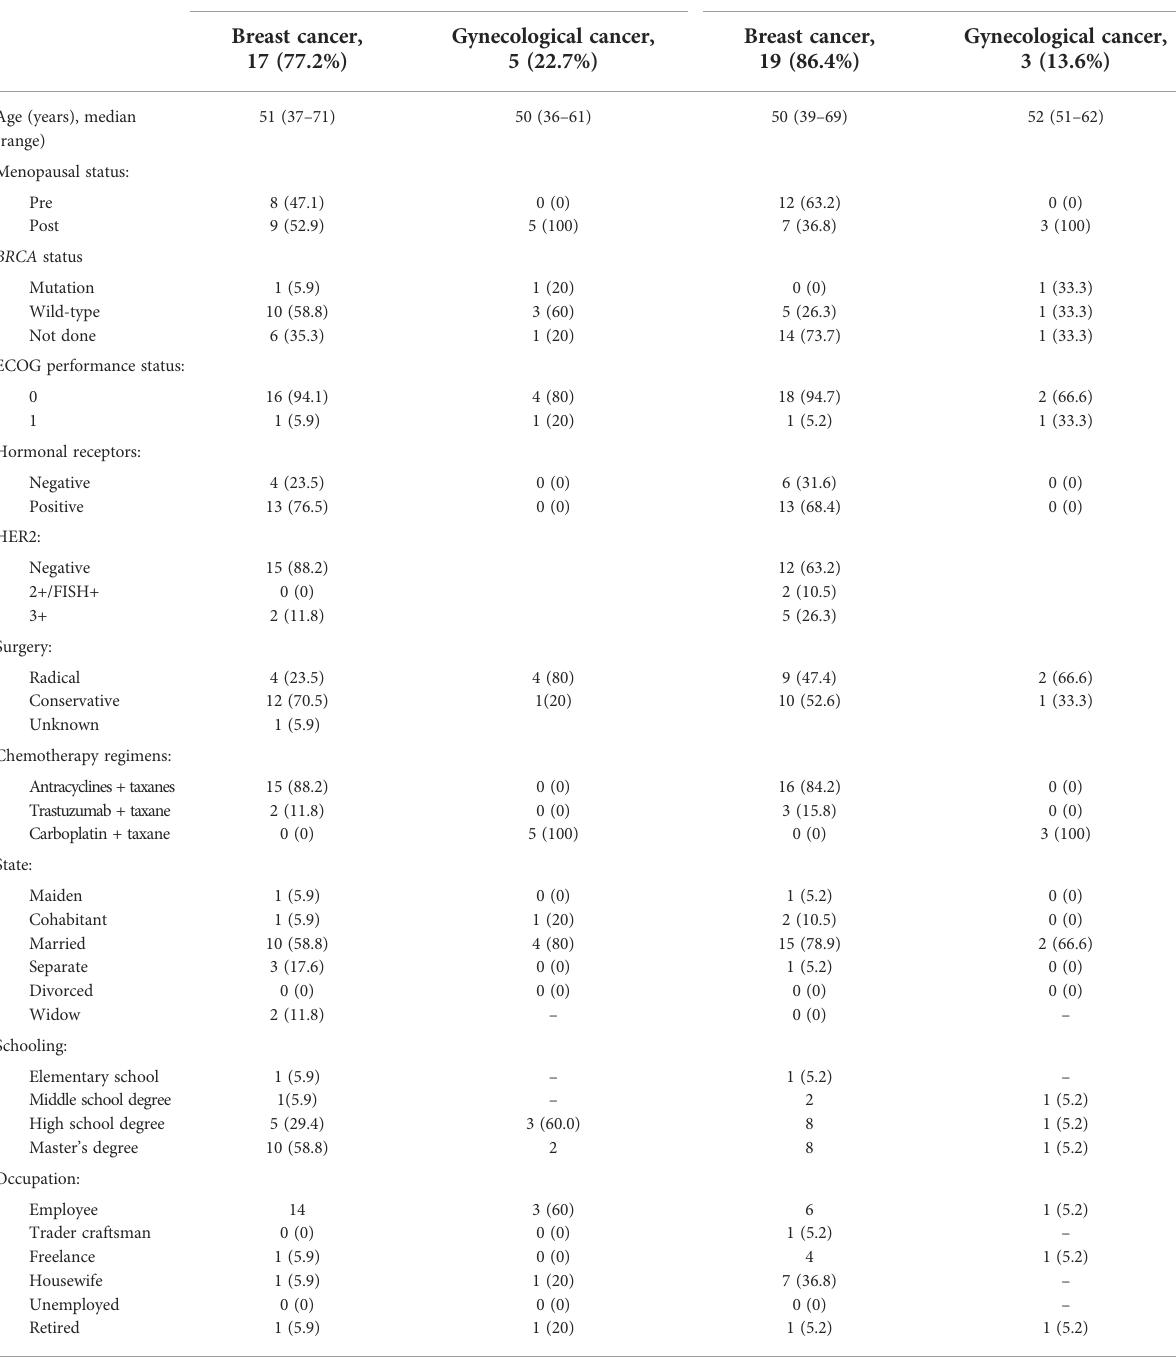
TABLE 2 Patient